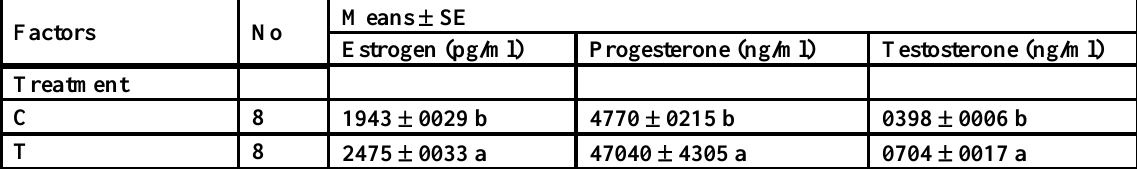
Table 4 Effects of N. sativa oil on Estrogen Progesterone and Testosterone in rats